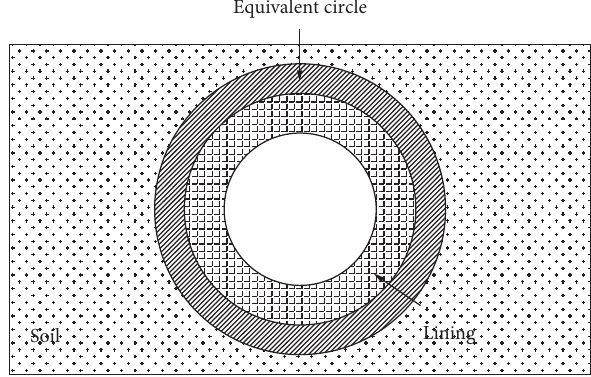
Figure 12: Sketch map of equivalent circle.